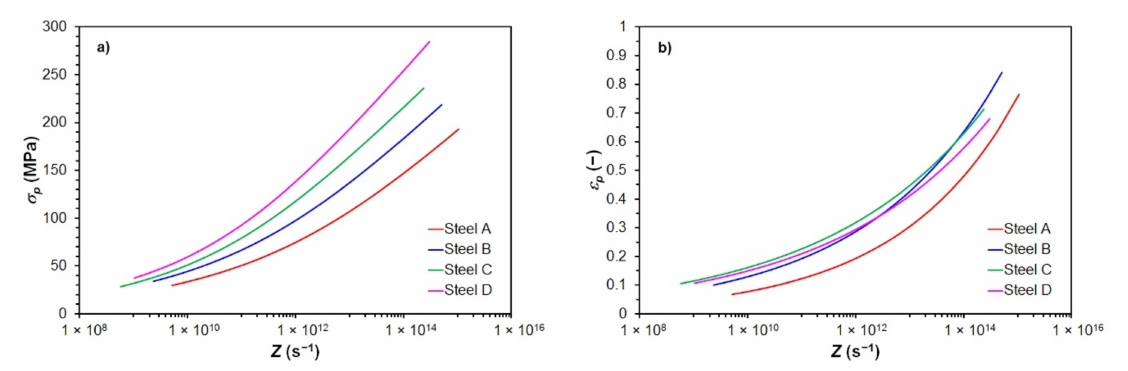
Figure 12. The effect of Zener–Hollomon parameter Z to the predicted values of σ p and of ε p of investigated steels: ( a ) peak flow stress σ p ; ( b ) peak strain ε p